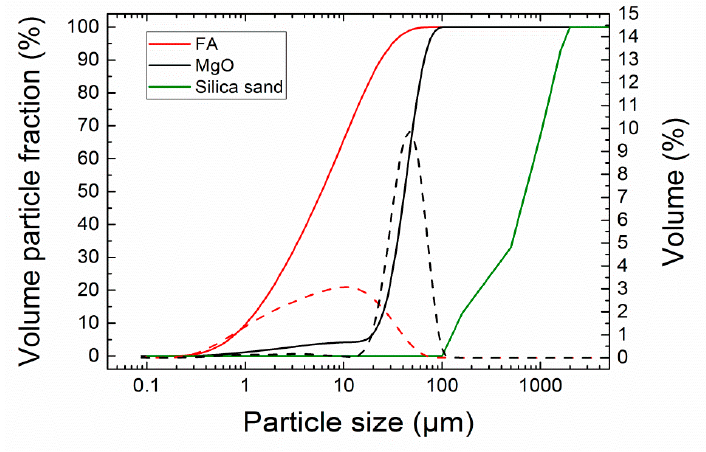
Figure 3. Particle size distribution of FA, MgO, and silica; dashed lines—incremental distribution curves, solid lines—cumulative curves sand.